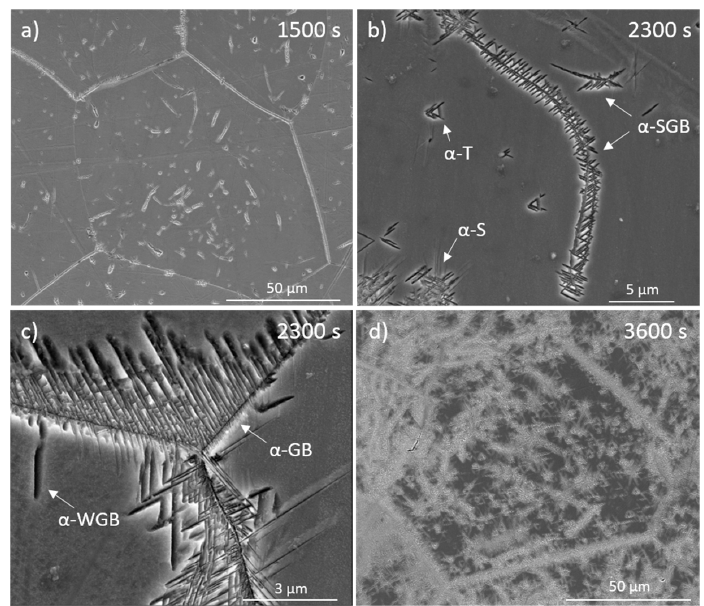
Figure 10. SEM images in SE mode showing ( a ) a β grain at t = 1500 s, ( b ) α phase precipitated from subgrain boundary ( α‐ SGB) and with triangular morphology ( α‐ T) and star ‐ like morphology ( α‐ S), ( c ) a grain boundary with Widmanstätten α ( α‐ WGB), grain boundary α ( α‐ GB), and a mixture of both ( α‐ WGB + α‐ GB) or the side plates [1] at t = 2300 s, and ( d ) a β grain at t = 3600 s (adapted from [49]).